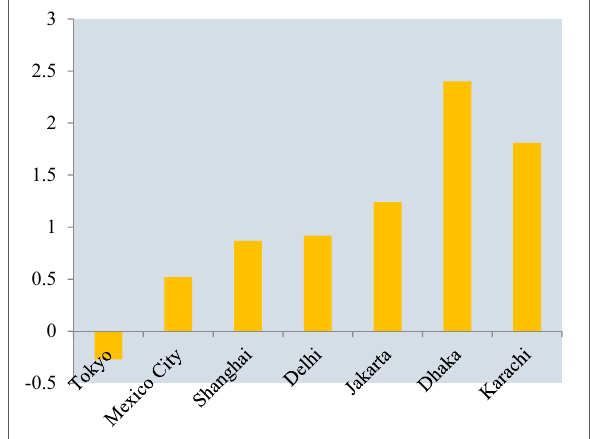
Figure 5. Comparative assessment of air quality in selected megacities [83]